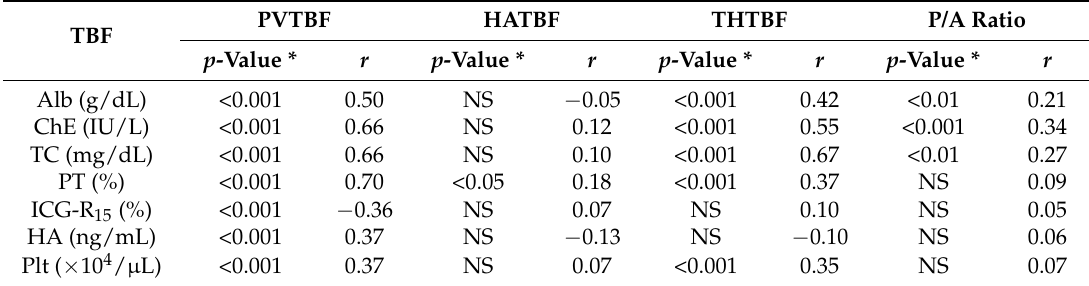
Table 6. Correlations of liver function and hepatic tissue blood flow in CHC.